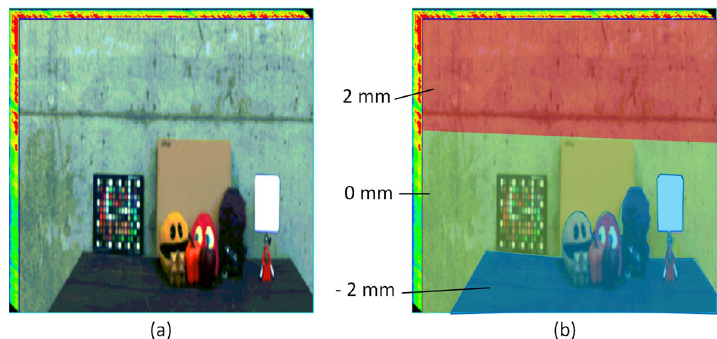
Fig. 5 The input datacube, a the datacube with size of 825 the blue region is 2 mm depth, the green one is 0 mm depth and the red one is 2 mm −